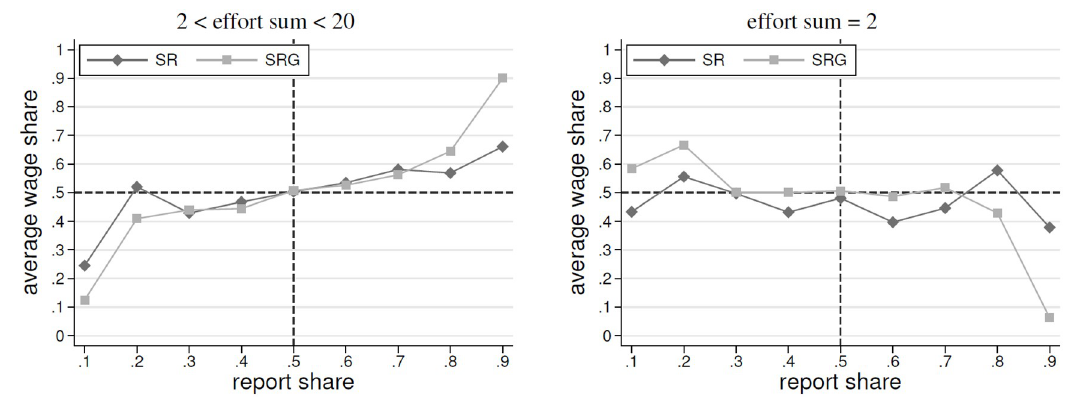
Fig 7. Average wage shares by share in